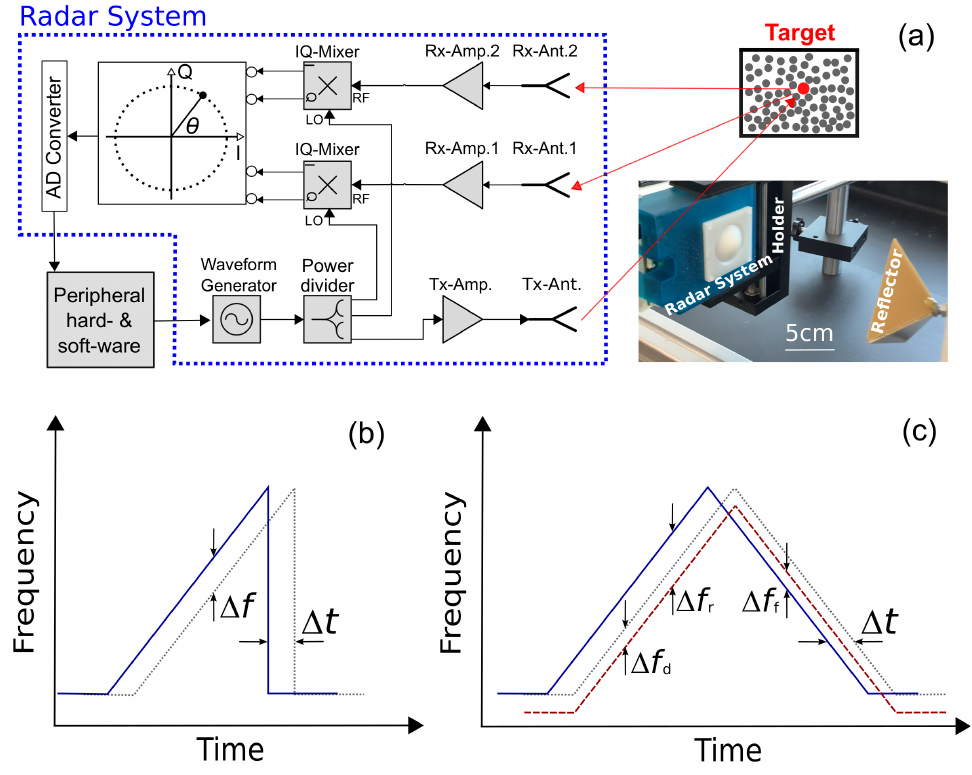
Figure 4: (a) A schematic diagram showing the working principle of a multi-static (i.e., transmission and receiving antennae are located differently) radar system. It is adapted from a previous work [51] to better present the on-chip radar system (see the picture on the lower right part). The corner reflector shown in the picture is used for calibration. (b) and (c) represent two scenarios for radar tracking in FMCW mode. Blue curves corresponding to the sweeping signal emitted at the transmission antennae, the dashed curves correspond to the received signal from static tracers, and the red curve in (c) represents the received signal in the presence of doppler shift induced by moving